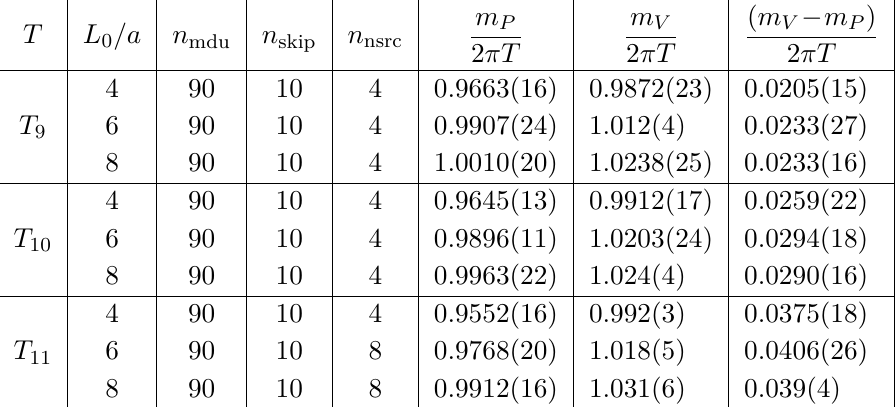
Table 9 . As in table 8 but for T 9 , T 10 and T 11